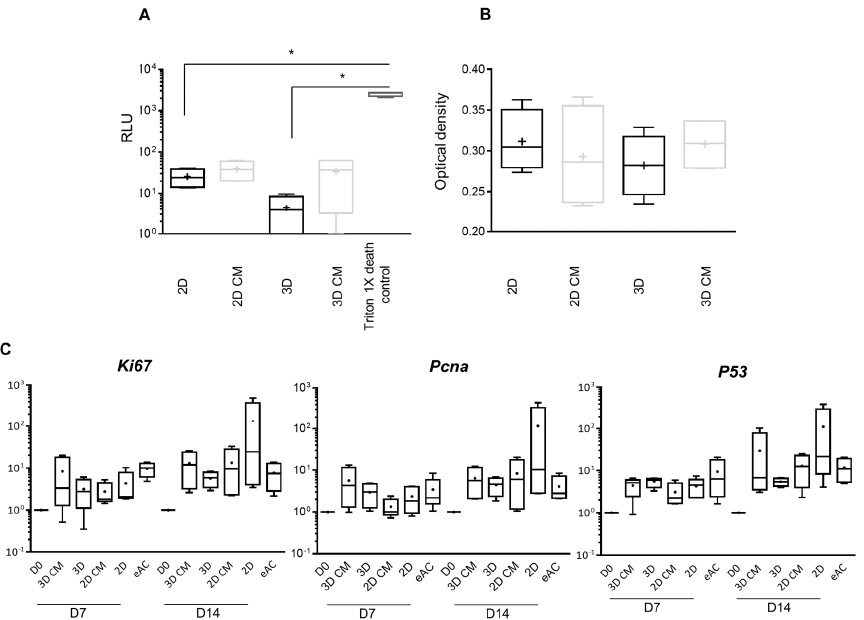
Figure 3. MSC-CM is not cytotoxic and does not affect eAC proliferation. eACs were seeded in 3D with type I/III collagen sponges or in 2D in monolayer until their confluency reached 80% then treated for 72 h to evaluate MSC-CM potential cytotoxicity with ToxiLight TM assay ( A ) and measure cell metabolic activity with XTT assay ( B ). For gene expression analysis, eACs were seeded in 3D with type I/III collagen sponges or in 2D in monolayer then treated 24 h later for 7 or 14 days ( C ). Total mRNA was extracted and RT-qPCR was performed to assess the mRNA levels of proliferation-associated molecules ( Ki67 , Pcna , and P53 ). The D0 condition corresponds to eACs cultured in monolayer until P3. The eAC condition corresponds to eACs at P0. mRNA levels were estimated by RT-qPCR after normalization relative to the β -actin reference gene. The results ( n = 4) are represented as box plots (median, quartiles, extreme values) and the statistical significance of the values between MSC-CM and respective control media was tested using the Mann–Whitney test (* p < 0.05). Note: 2D-for medium used for chondrocyte amplification; 2D CM-for 2D-conditioned medium incubated with MSCs for 24 h and filtered; 3D-for medium used for chondrocyte redifferentiation; 3D CM-for 3D-conditioned medium incubated with MSCs for 24 h and filtered. D0-corresponds to untreated eACs cultured in monolayer until P3. D7-time point corresponding to the cells cultured for 7 days; D14-time point corresponding to the cells cultured for 14 days; eACs-equine articular chondrocytes; Ki67 -gene encoding the Ki67 mRNA, MSCs-mesenchymal stem cells; P0-primary culture; P3-passage 3; P53 -gene encoding the P53 mRNA; Pcna -gene encoding proliferating cell nuclear antigen mRNA; RLU-relative luciferase unit; RT-qPCR-reverse transcription- quantitative polymerase chain reaction; Triton 1X death control-eACs cultured for 72 h in 2D medium, then Triton 1X is added at 72 h to induce cell